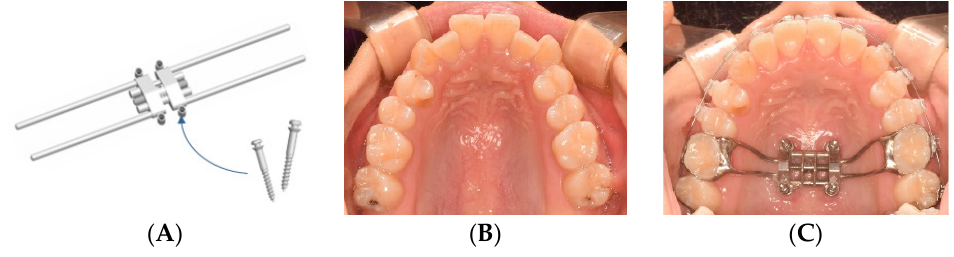
Figure 1. ( A ) MSE II appliances. ( B ) Initial state. ( C ) After